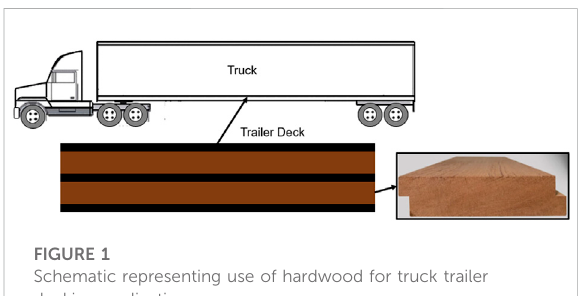
FIGURE 1 Schematic representing use of hardwood for truck trailer decking